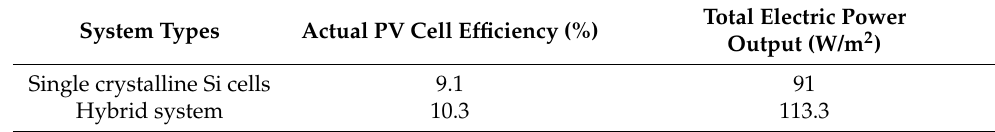
Table 3. Performance analysis of the traditional PVC hybrid system.